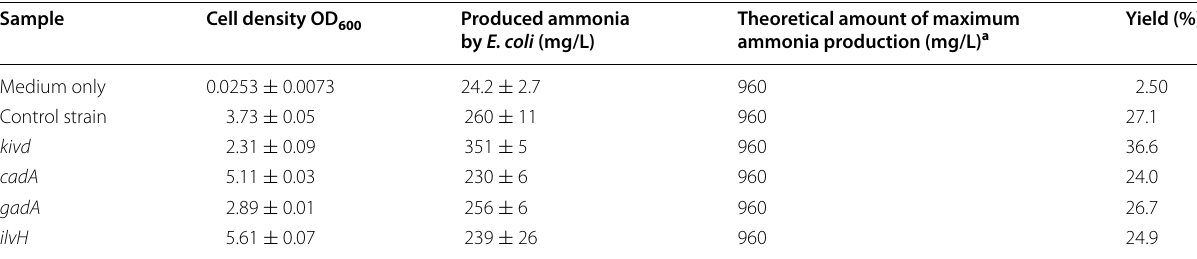
Table 2 Growth and ammonia production of decarboxylase-overexpressing E. coli strains in M9_YE medium